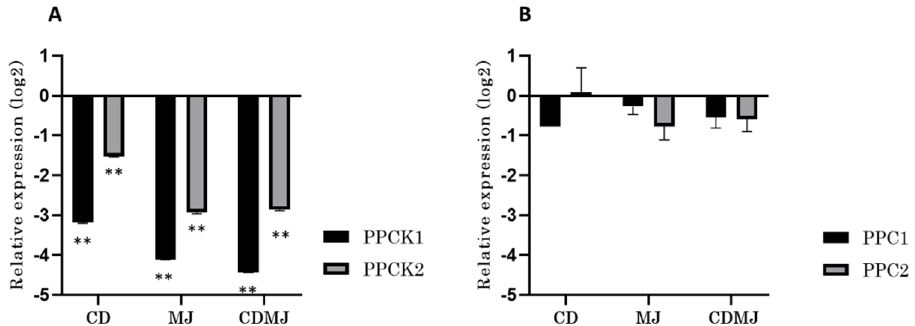
Figure 1. Analysis of grapevine PPCK and PPC genes expression in Gamay cell cultures in response to elicitation. ( A ) RT-qPCR analysis of VvPPCK1 and VvPPCK2 in cell cultures treated with elicitors CD, MJ, and CDMJ for 24 h. ( B ) RT-qPCR analysis of VvPPC1 and VvPPC2 in cell cultures treated with elicitors CD, MJ, and CDMJ for 24 h. Transcript levels were normalized to the reference gene VvEF1-alpha , and values are presented as relative expression to the control treatment. (* p -value < 0.05; ** p -value <